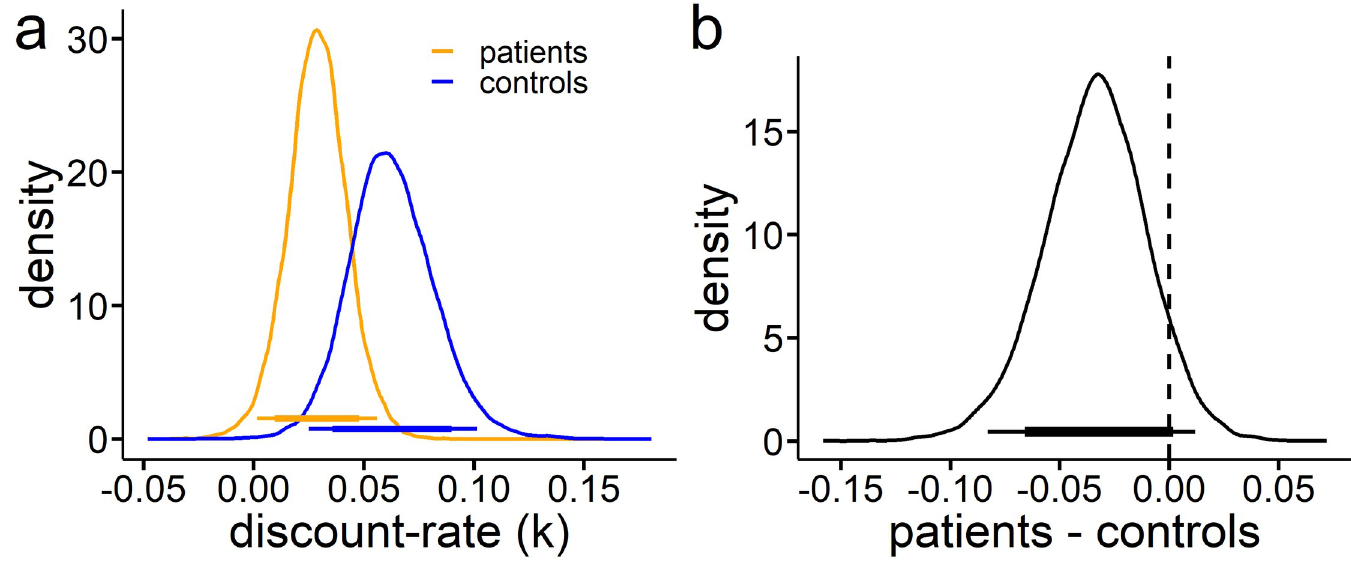
Fig 1. a , Group level hyperparameter distributions of the discount-rate parameter k revealed that discounting was lower in adolescents with TS (orange) when compared to controls (blue). b, Difference distribution of controls—adolescence with TS. Bayes factor for directional effects (dBF) indicated that a decrease in discount-rate ( k ) in patients was 12.52 times more likely than an increase. Thin and thick colored (a) and black (b) bars indicate the 95% and 85% highest density intervals respectively. TS, Tourette